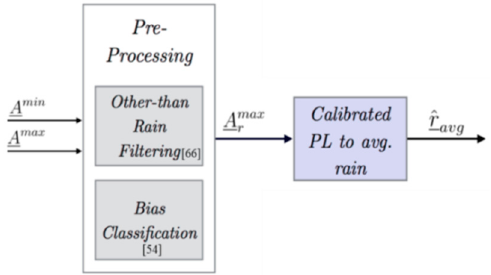
Figure 1 . A possible workflow for rain estimation from passive measurements, where appropriate power-law (PL) is adjusted to maximum attenuation (after J. Ostrometzky [15]).